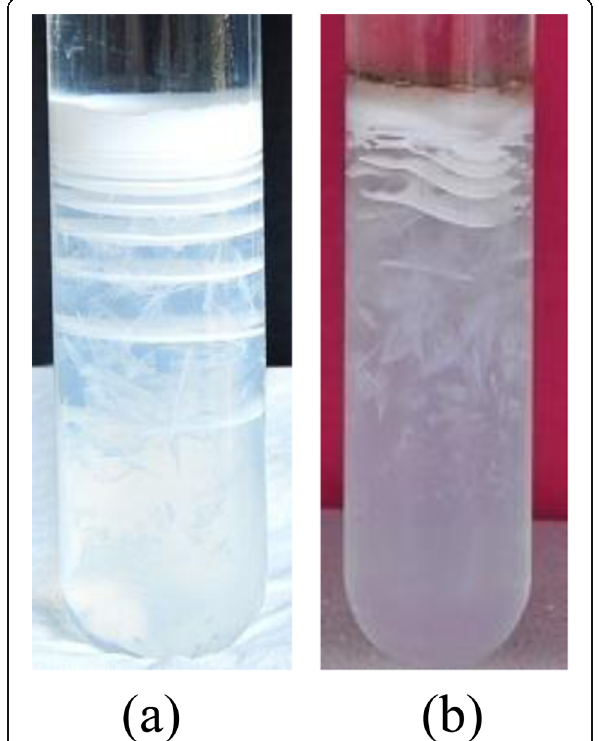
Fig. 2 CHPD (Brushite) crystals grown in gel medium ( a ) Without Inhibitor, ( b ) 50 mg of A. marmelos added CHPD